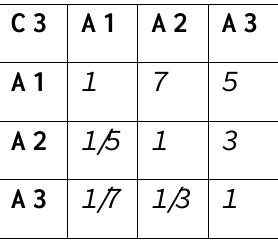
Table 4.5 Matrix M4: comparison of alternatives by the ratio of preference with respect to the criterion